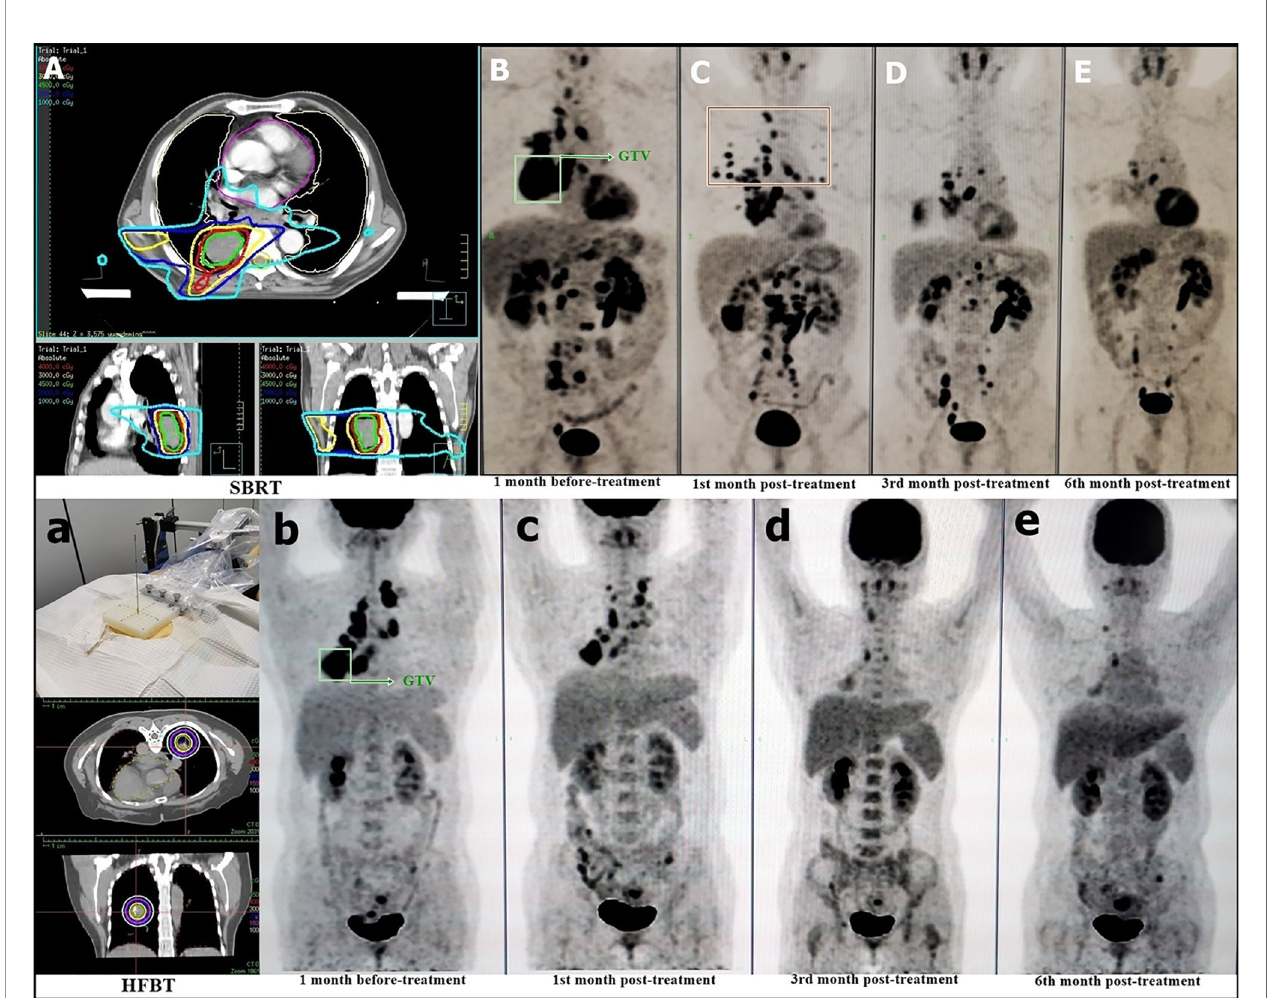
FIGURE 2 | HFRT Treatment and Patient Response. The beam plan and dose distribution of SBRT on the selected lesion (A) PET – CT evaluation of pre-treatment (B) post-treatment at the fi rst month (C) , third month (D) , and sixth month (E) . The dose distribution of HFBT on the selected lesion (a) PET – CT evaluation of pre- treatment (b) post-treatment at the fi rst month (c) , third month (d) , and sixth month (e) . The green box shows the irradiated lesions for HFRT treatment (B, b) .